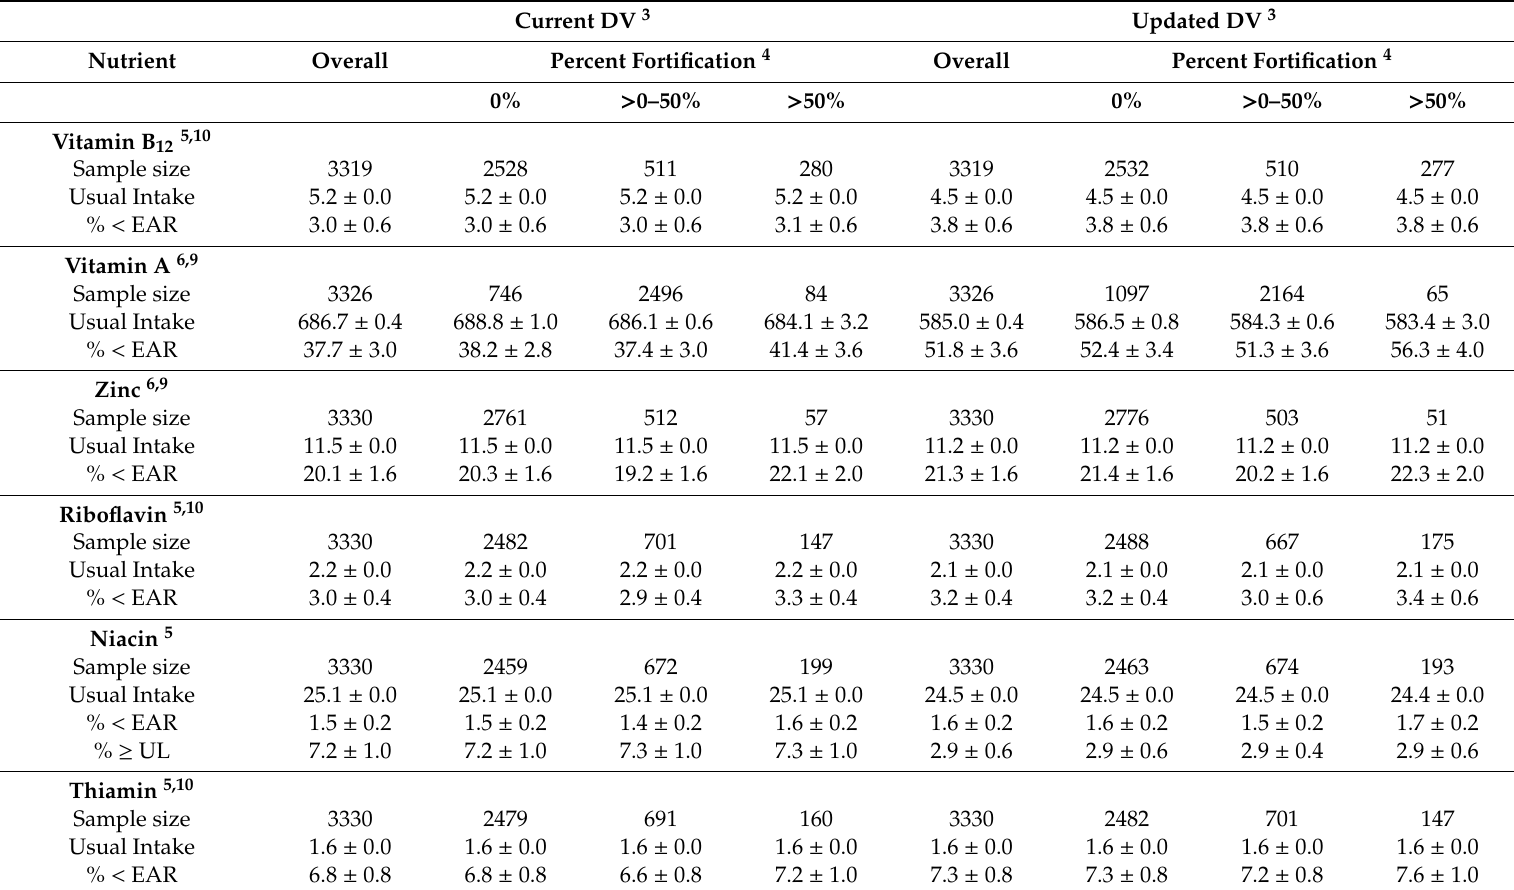
Table A4. Comparison of Current Daily Value (DV) and Updated DV nutrient intake models with overall and percent fortification subgroups for US adults (51–70 years of age) (Mean ± SEM) 1,2